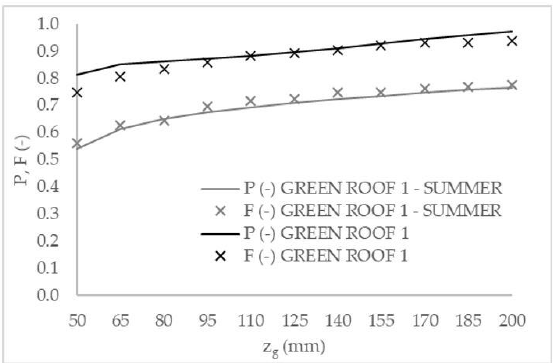
Figure 4. Probability ( P ) and frequency ( F ) distribution function of water content into growing medium varying its thickness ( z g ) during the whole year and summer, GREEN ROOF 1.